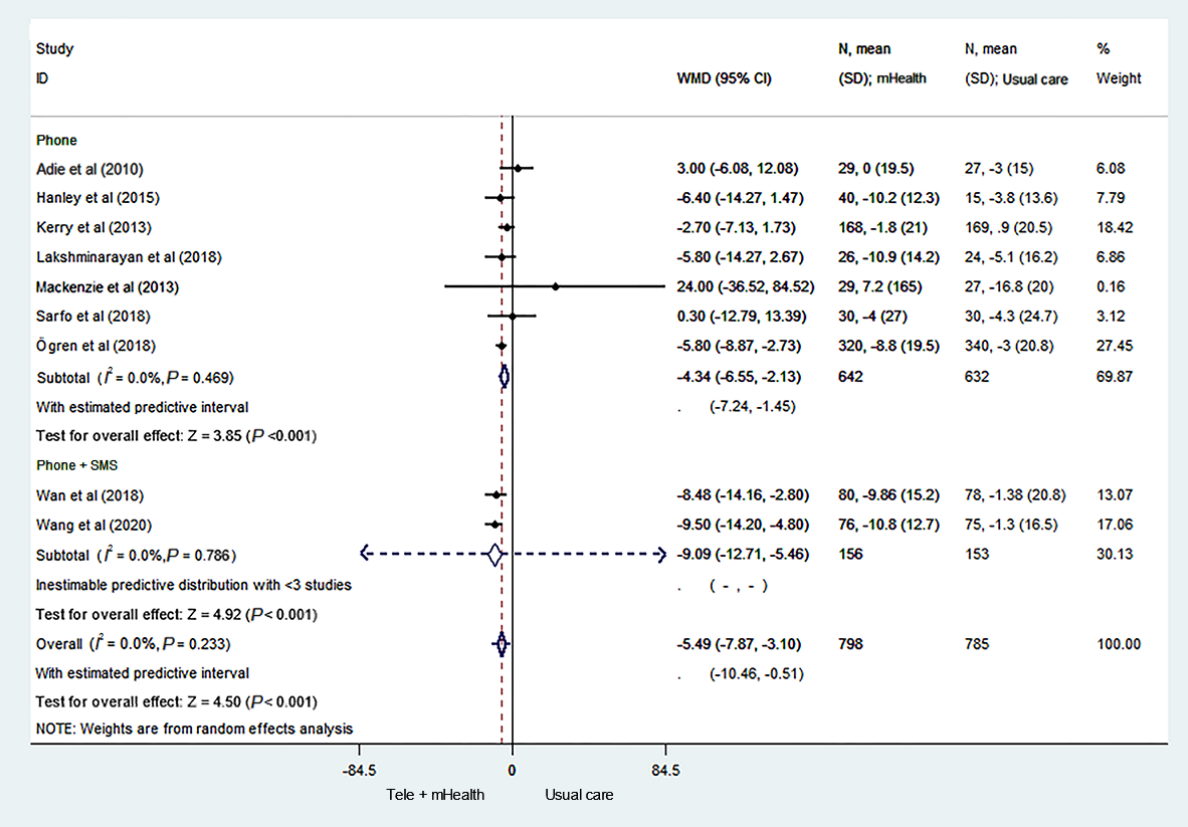
Figure 3. Forest plot of the subgroup analysis of the mode of intervention. mHealth: mobile health; WMD: weighted mean